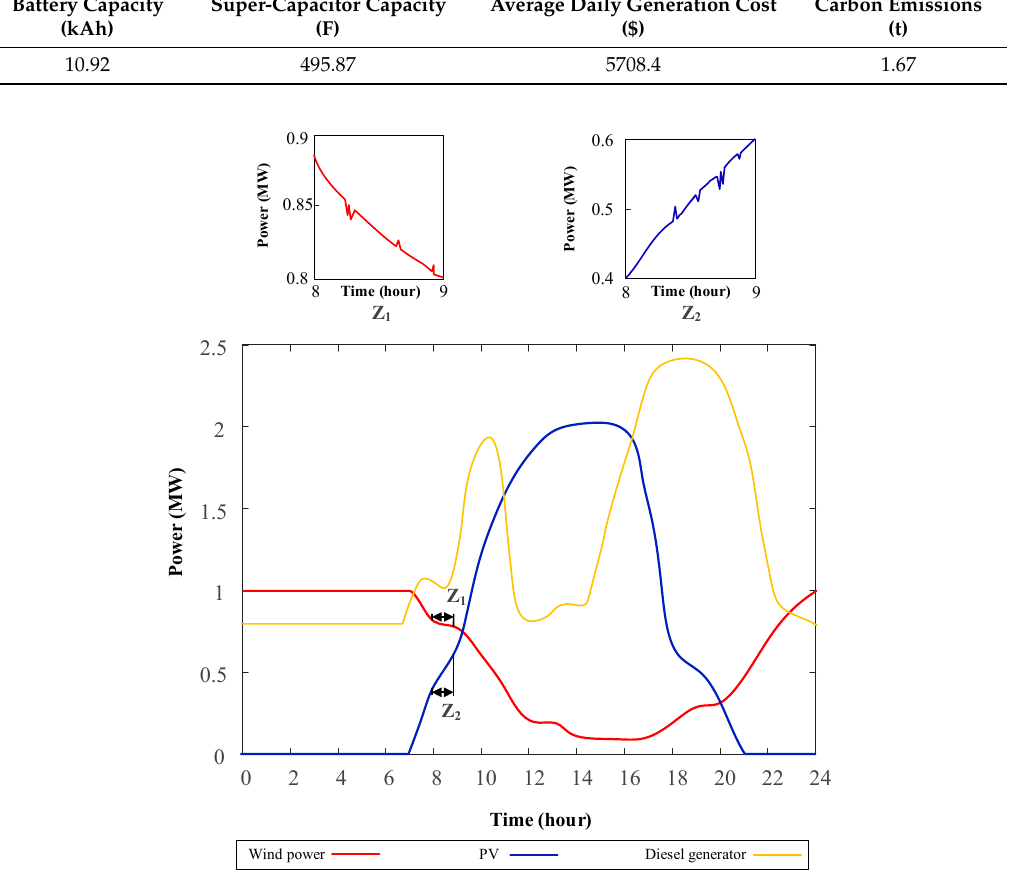
Figure 6. Real-time output power different power generators.